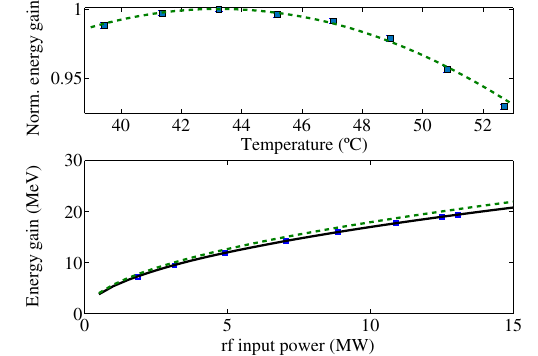
FIG. 23. Measured beam energy gains (blue squares) for the X-band structure as a function of operating temperature (top) and rf input power (bottom). The dashed lines correspond to the design expectation, the solid line is the square-root fit used to extract the structure ’ s gradient-to-power ratio.